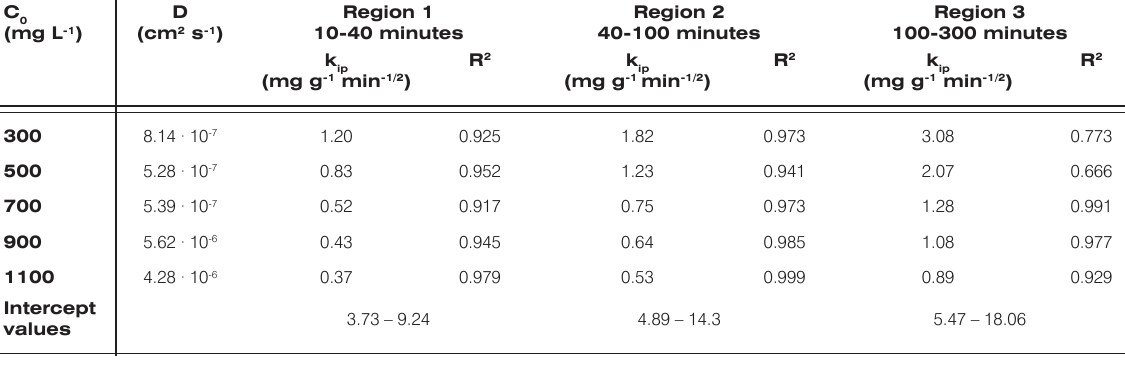
Table 5. Liquid film diffusion rate coefficients for removal of zinc on Amberlite IRA410 at different initial concentrations. C 0 (mg L -1